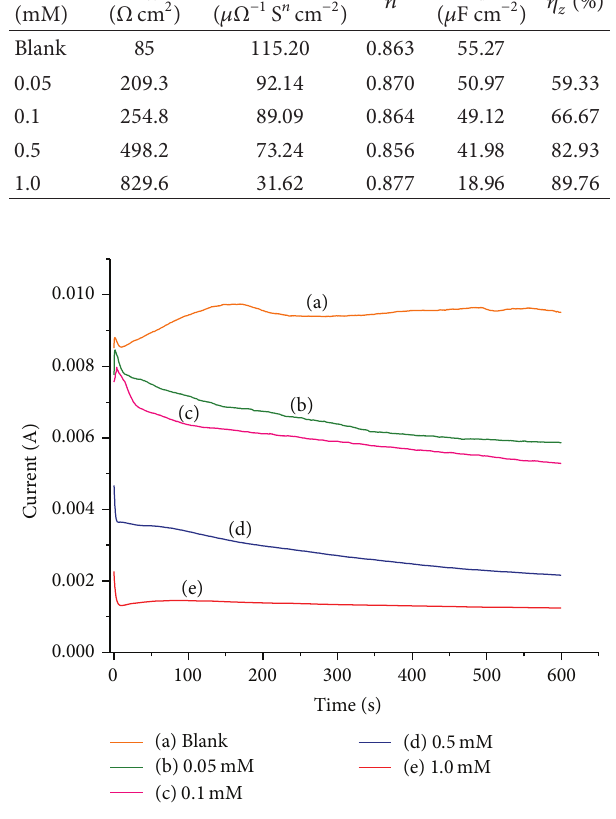
Figure 10: Chronoamperometric curves of mild steel in 1M HCl without and with different concentrations of